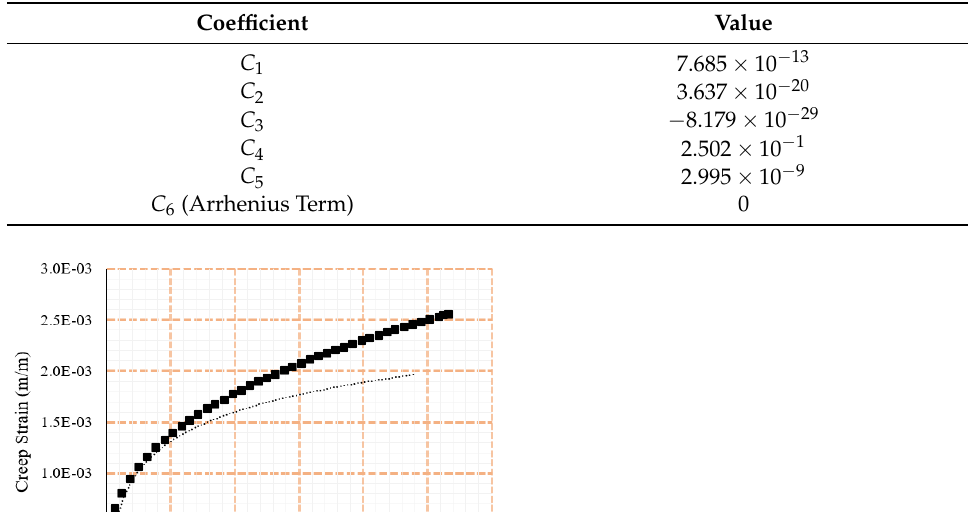
Table 4. Compressive Creep Coefficients from the Group Generalised Time Hardening simulations.